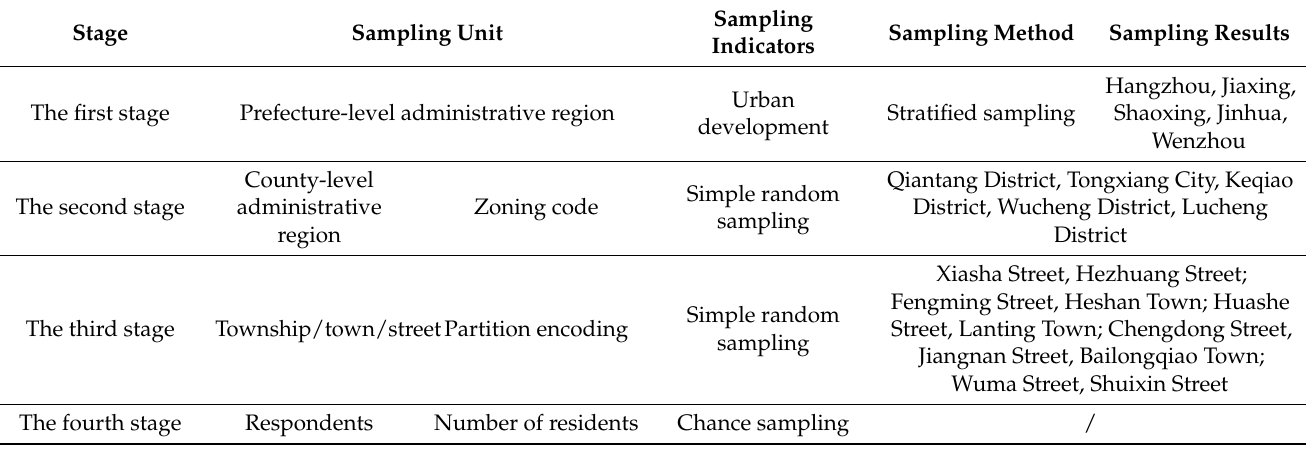
Table A1. Population sampling